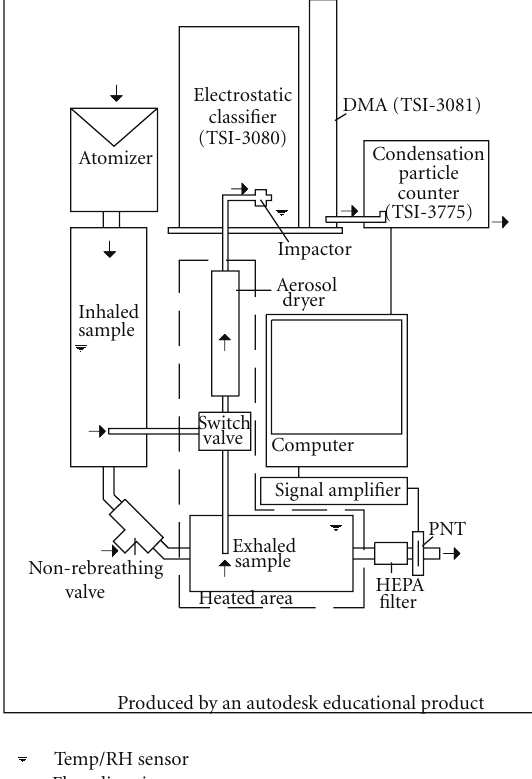
Figure 1: Layout of flow-through breath sampling